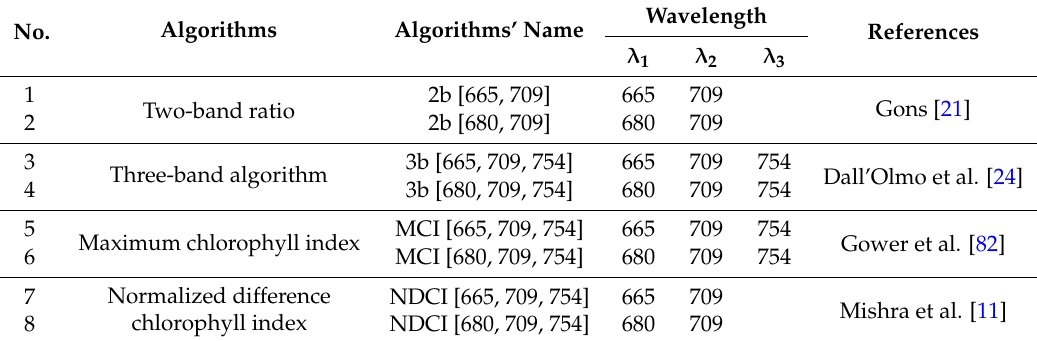
Table 3. The incorporated band for each